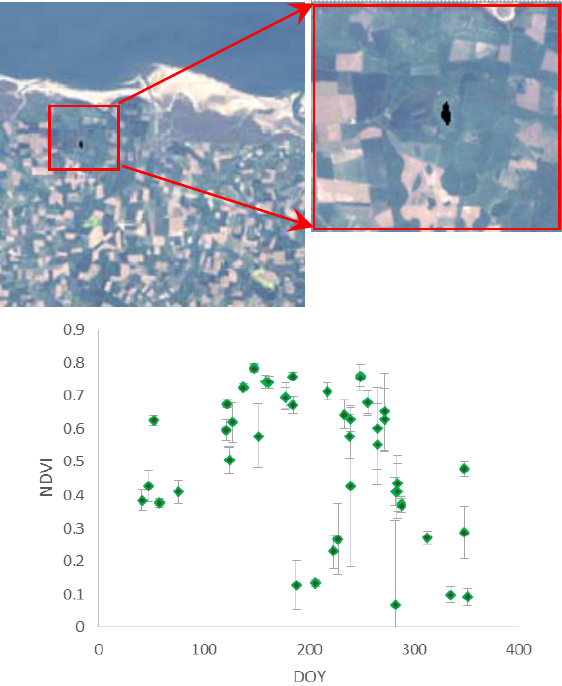
Figure 3. Landsat 5 TM and 7 ETM+ dataset shown as the area under investigation (top left), zoomed in to show the polygon being extracted (top right). There’s also (bottom) a plot of the mean NDVI values versus the DOY where the error bars indicate the variability within the